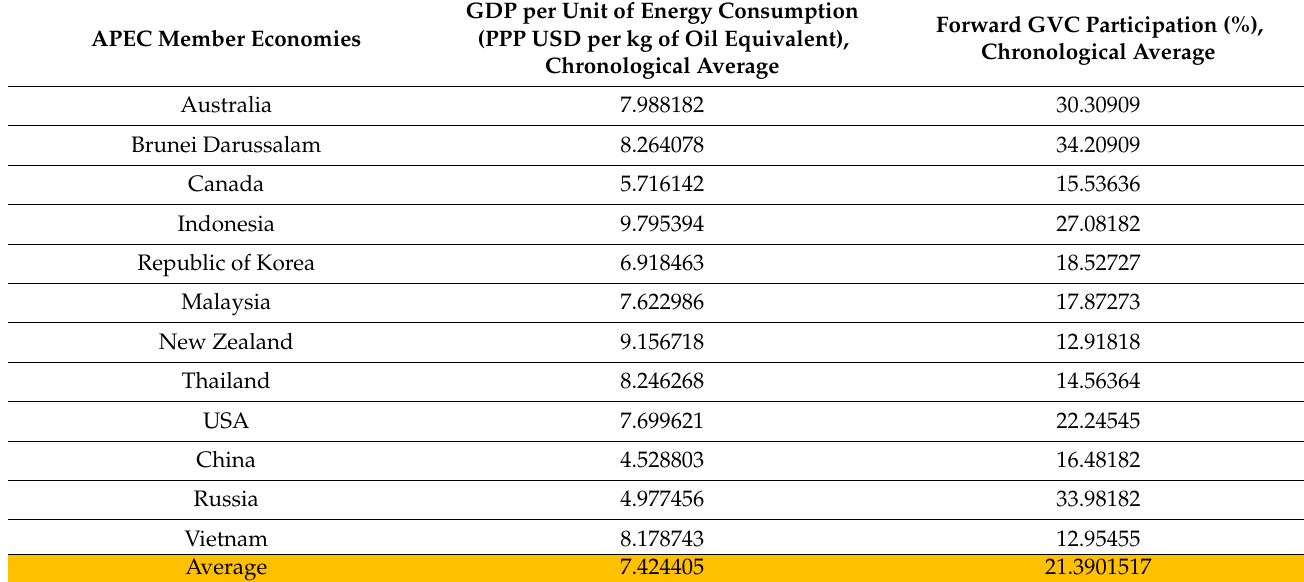
Table 7. APEC member economies with lower GDP per unit of energy